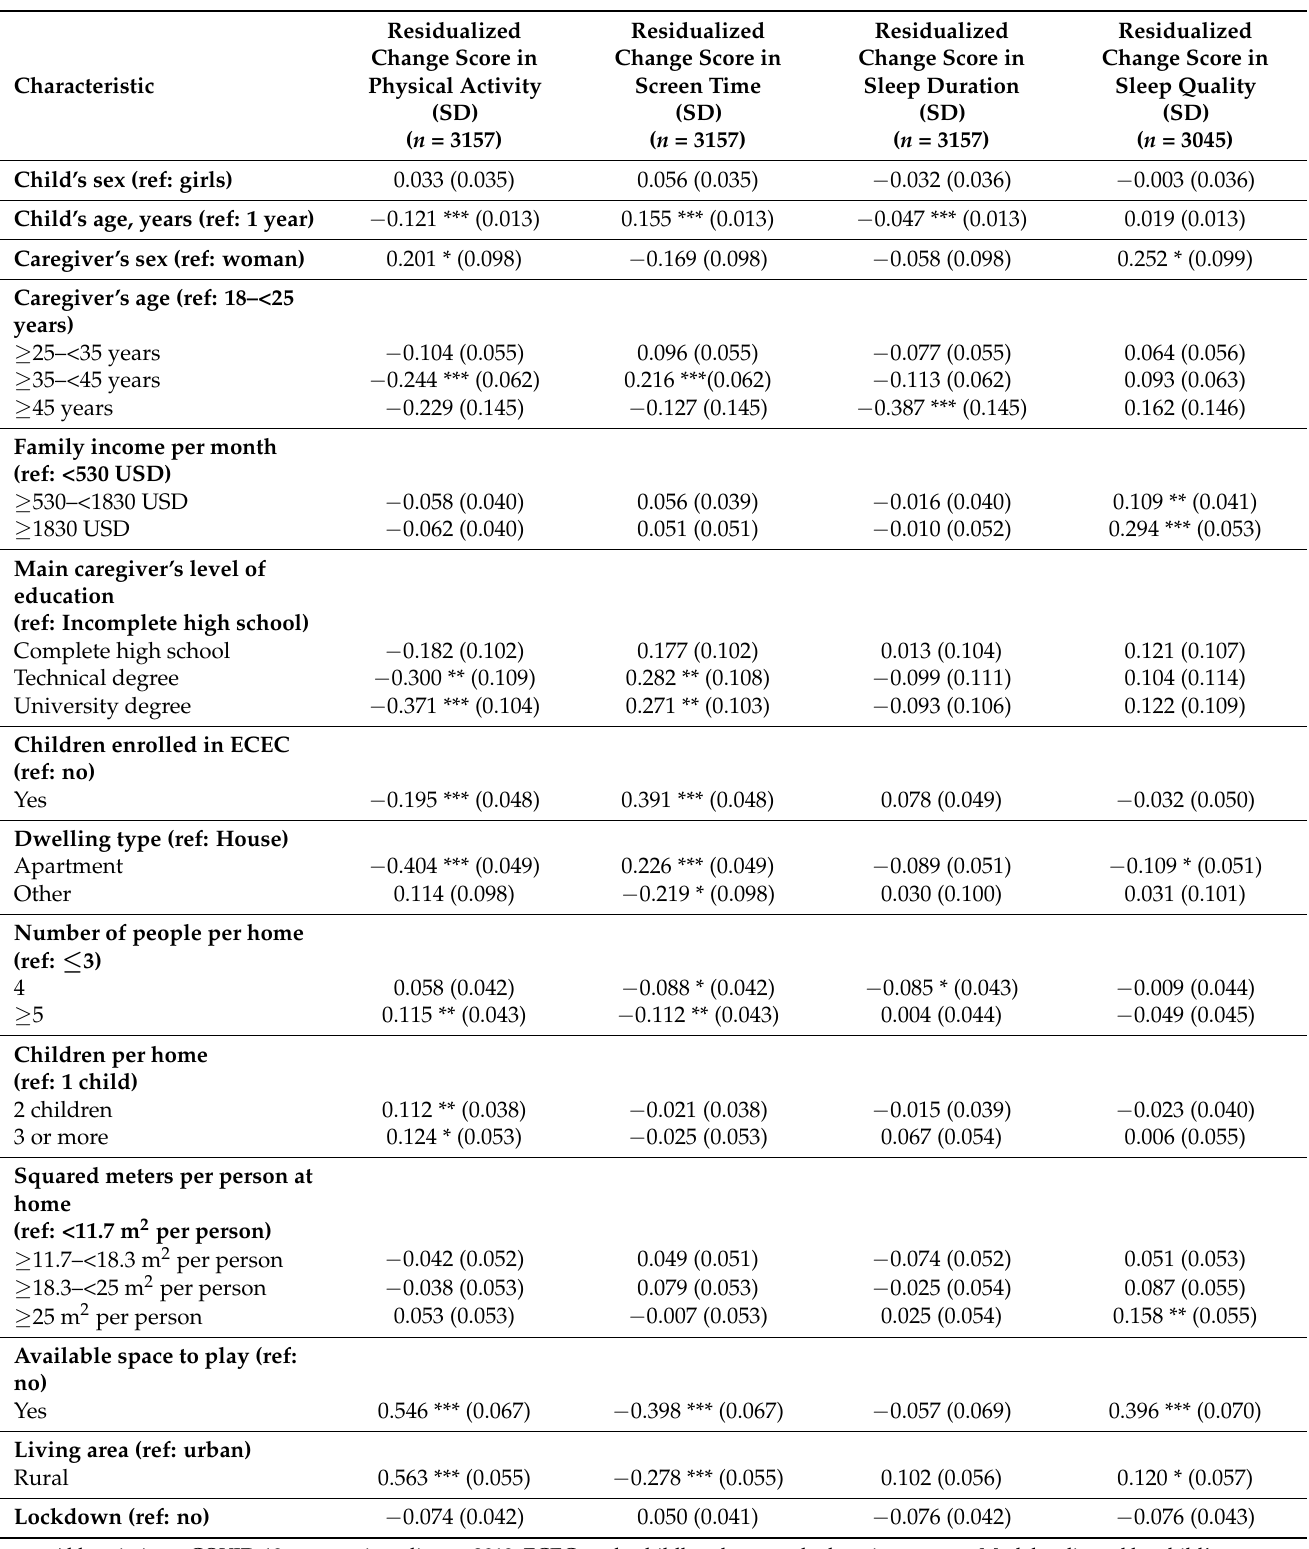
Table 3. Sociodemographic predictors of change in movement behaviors in toddlers and preschoolers during COVID-19 pandemic in